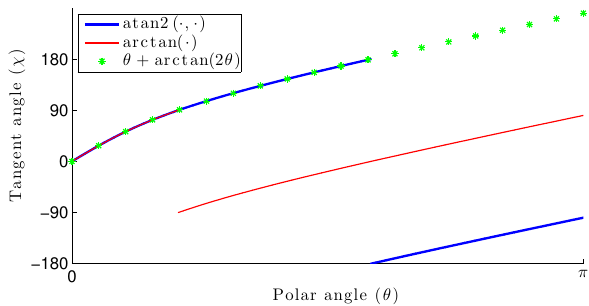
Figure 12: Course tangent angle. Only the expression θ + arctan(2 θ ) is